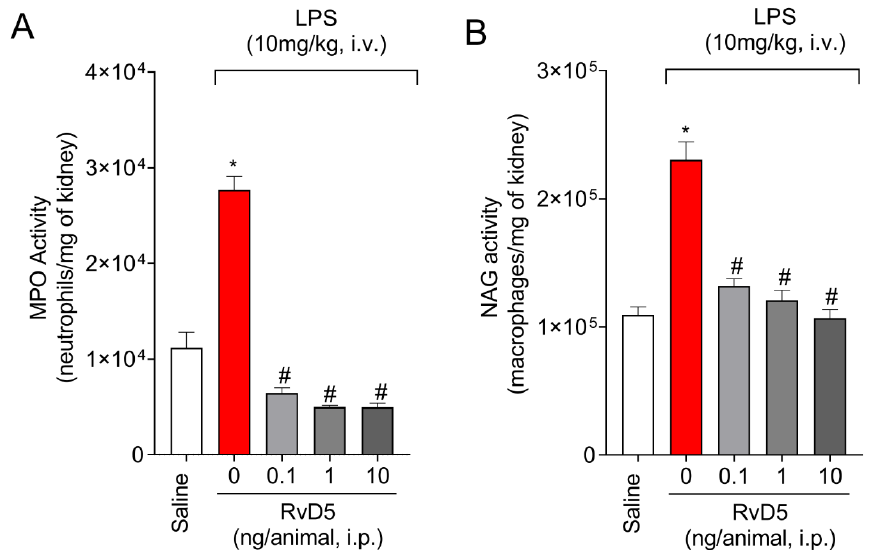
Figure 2. RvD5 decreased MPO and NAG activities in the kidneys. MPO ( A ) and NAG ( B ) activities were determined in kidney samples. Results are presented as mean ± SEM of six animals per group and are representative of two replicates. (* p < 0.05 vs. saline, # p < 0.05 vs. LPS 10 mg/kg; one-way ANOVA followed by Tukey’s